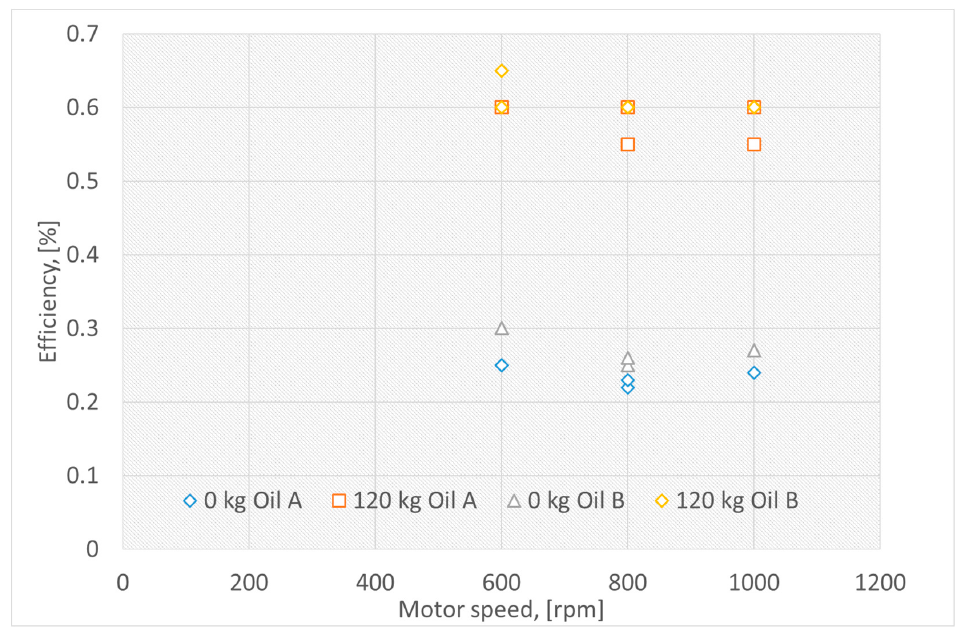
Figure 3. Measured data: DDH system total efficiency during lifting with various motor speed rpm and payload of 0 and 120 kg with oils A and B at ambient temperature +22 °C.